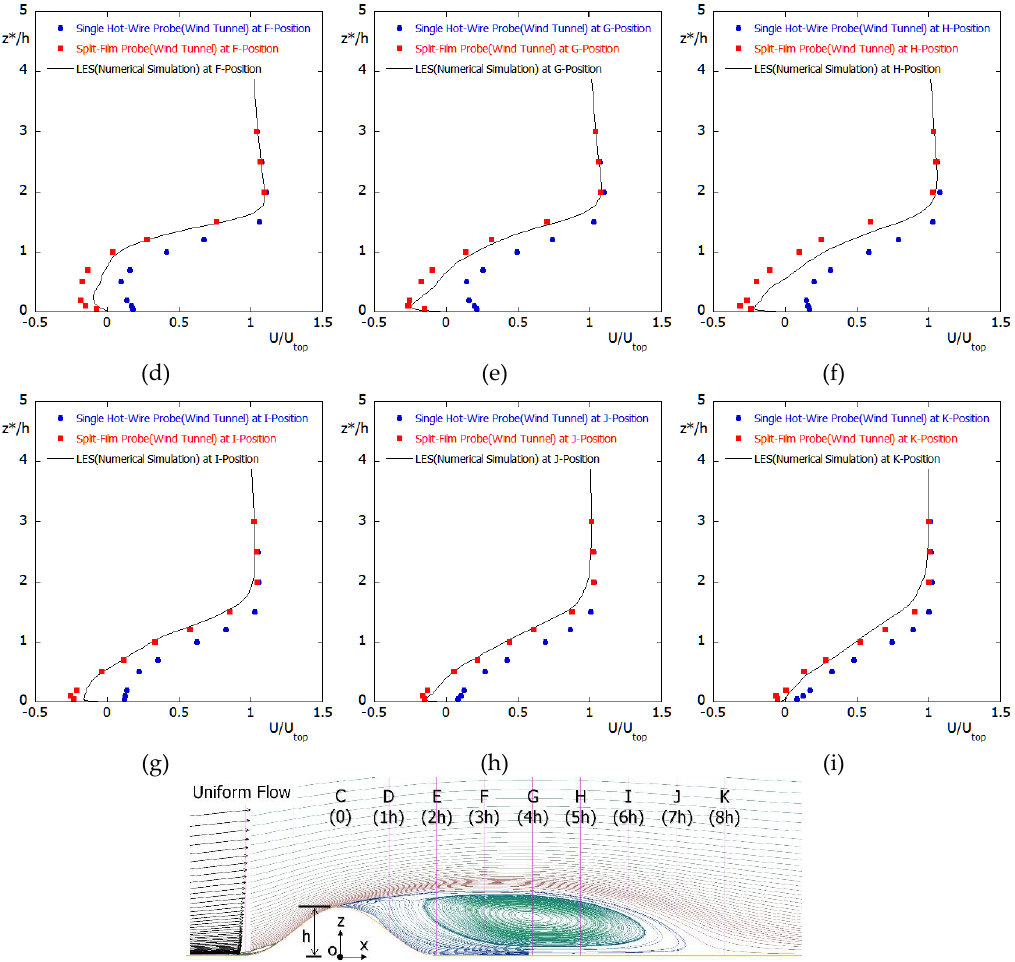
Figure 6. Comparison of nondimensional mean velocity profiles in the wind tunnel experiment and numerical simulation. Numerical flow visualization shows the flow field with time averaging and spatial averaging in the spanwise direction. (a) x = 0h, (b) x = 1h, (c) x = 2h, (d) x = 3h, (e) x = 4h, (f) x = 5h, (g) x = 6h, (h) x = 7h, and (i) x = 8h.